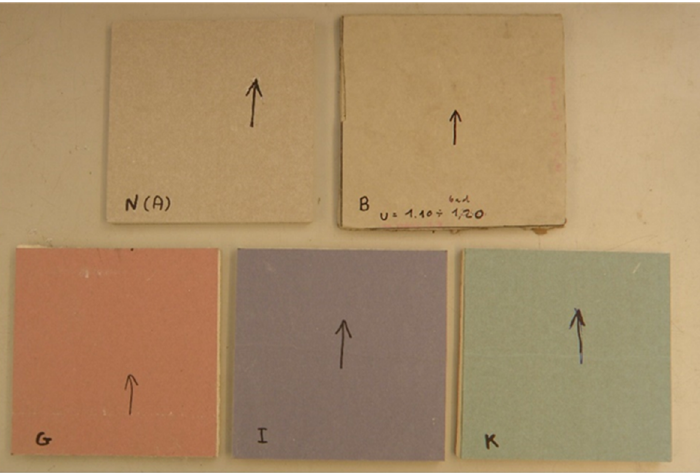
Figure 1. View of five types of square 200 × 200 mm plasterboard specimens prepared for examination.